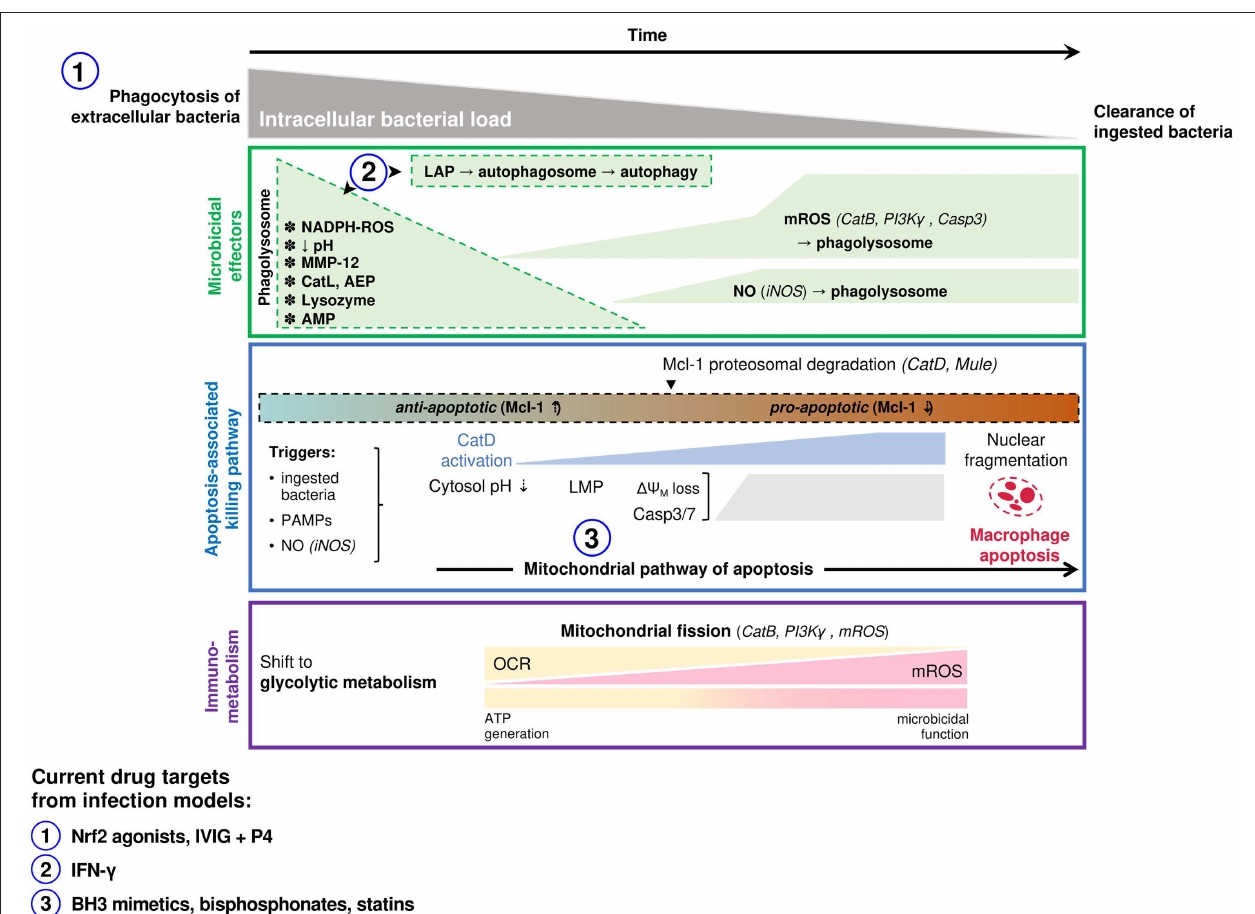
FIGURE 2 | Macrophage microbicidal responses involved in successful clearance of extracellular bacterial pathogens. Macrophage responses to ingested extracellular bacteria (e.g., S. pneumoniae, S. aureus, P. aeruginosa ) are summarized. Following phagocytosis of bacteria an initial microbicidal response occurs in the phagolysosome (top panel). Specific effectors with demonstrated microbicidal roles differs based on the ingested organism, and include NADPH derived ROS, MMP-12 ( S. aureus ), cathepsin L ( S. aureus ), asparagine endopeptidase ( P. aeruginosa ), lysozyme and antimicrobial peptides. Microbicidal species produced later that co-localize to bacteria-containing phagolysosomes include NO and mROS which have demonstrated roles in killing ingested pneumococci. A mitochondrial pathway of host-directed apoptosis is engaged in response to live ingested pneumococci, involving recognition of pneumolysin and accumulation of NO (middle panel). This has been best studied in pneumococcal models, where it allows pauci-inflammatory clearance of bacteria that have survived initial phagolysosomal killing, but may occur for other extracellular bacteria also. Immuno-metabolic changes that underpin the microbicidal function of macrophages have also been characterized well in pneumococcal models and also in some other extracellular bacterial infections (bottom panel). This involves an early shift to glycolysis and a progressive transition of mitochondrial function from ATP generation (oxidative phosphorylation) to become microbicidal organelles (mROS generation). Targets of host-directed therapeutics that have been investigated in infection studies (clinical or pre-clinical) are indicated. The number corresponding to each indicates the stage in the killing process where it acts, as indicated on the panels above. LAP, LC-3 associated phagocytosis; MMP, matrix metalloproteinase; Cat, cathepsin; AEP, asparagine endopeptidase; AMP, antimicrobial peptide; ROS, reactive oxygen species; mROS, mitochondrial ROS; NO, nitric oxide; PI3K, phosphoinositide 3-kinase; Casp, caspase; iNOS, inducible nitric oxide synthase; Mcl-1, myeloid cell leukemia-1; PAMP, pathogen-associated molecular pattern; LMP, lysosomal membrane permeabilization; 1 9 M , mitochondrial membrane potential; OCR, oxygen consumption rate; IVIG, intravenous immunoglobulin; IFN,